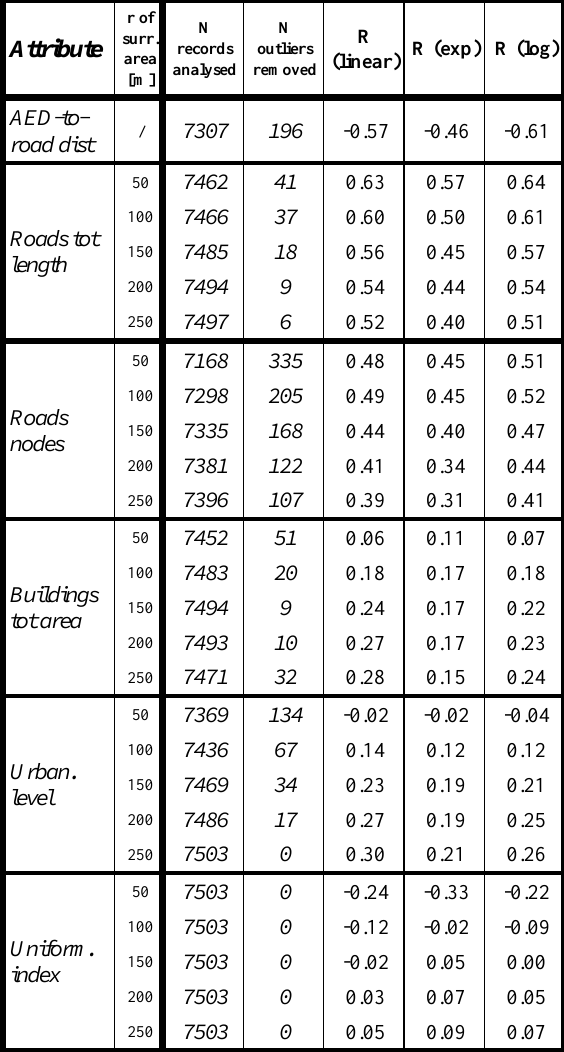
Table 1. Correlation coefficients R for all the attributes (see text at 2.4 for definition details) with the ‘error’ (difference between realistic and circular catchment areas), not transformed, exponentially transformed and logarithmically